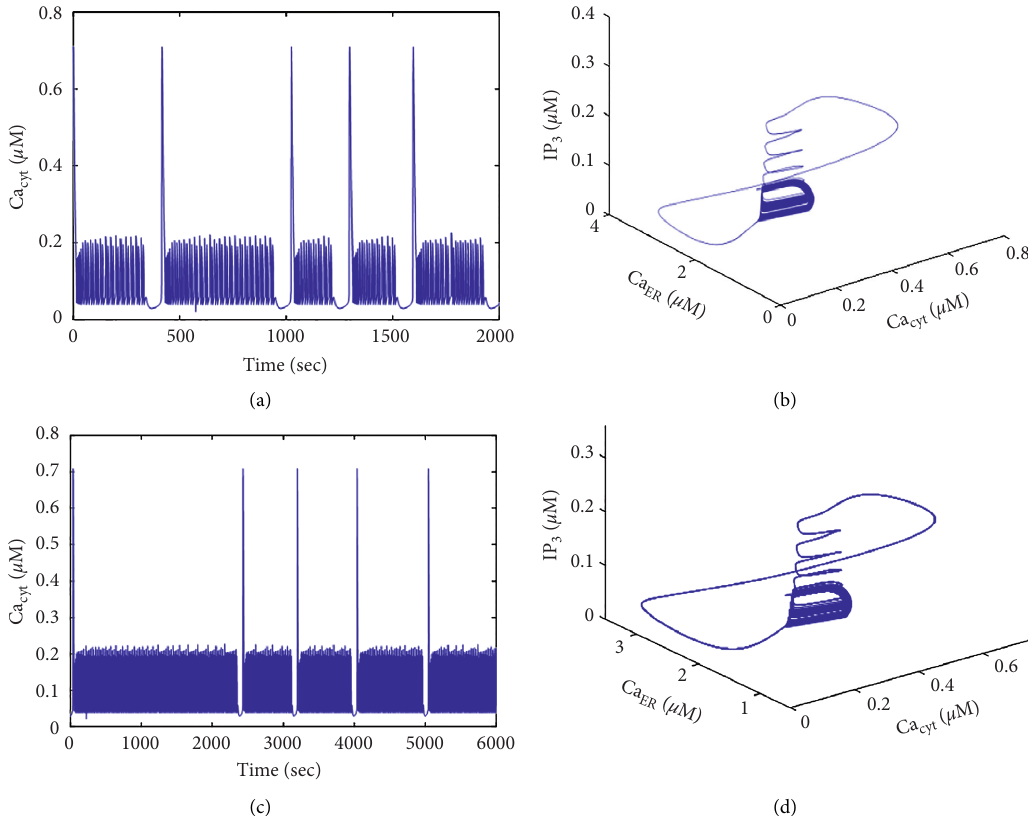
Figure 3: Time evolution of chaotic burst spontaneous Ca 2+ oscillations in astrocytes. (a) v � 0.05025 μ M/s. (c) v � 0.050252 μ M/s. (d) 3D phase portrait diagram in ( x , y , z )-plane for v in ( x , y , z )-plane for v in in